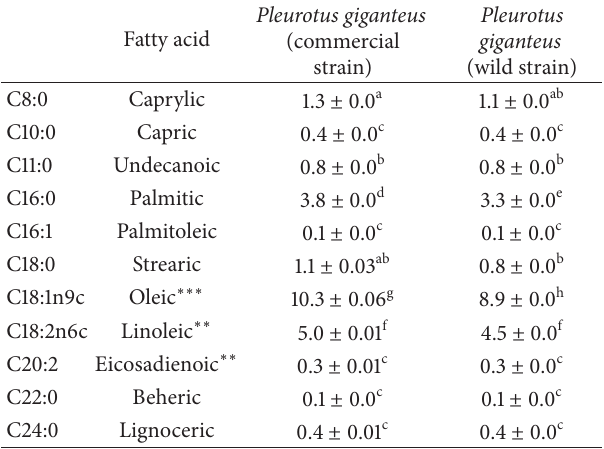
Table 3: Fatty acids (g kg − 1 dry weight) detected in the basidiocarps of Pleurotus giganteus